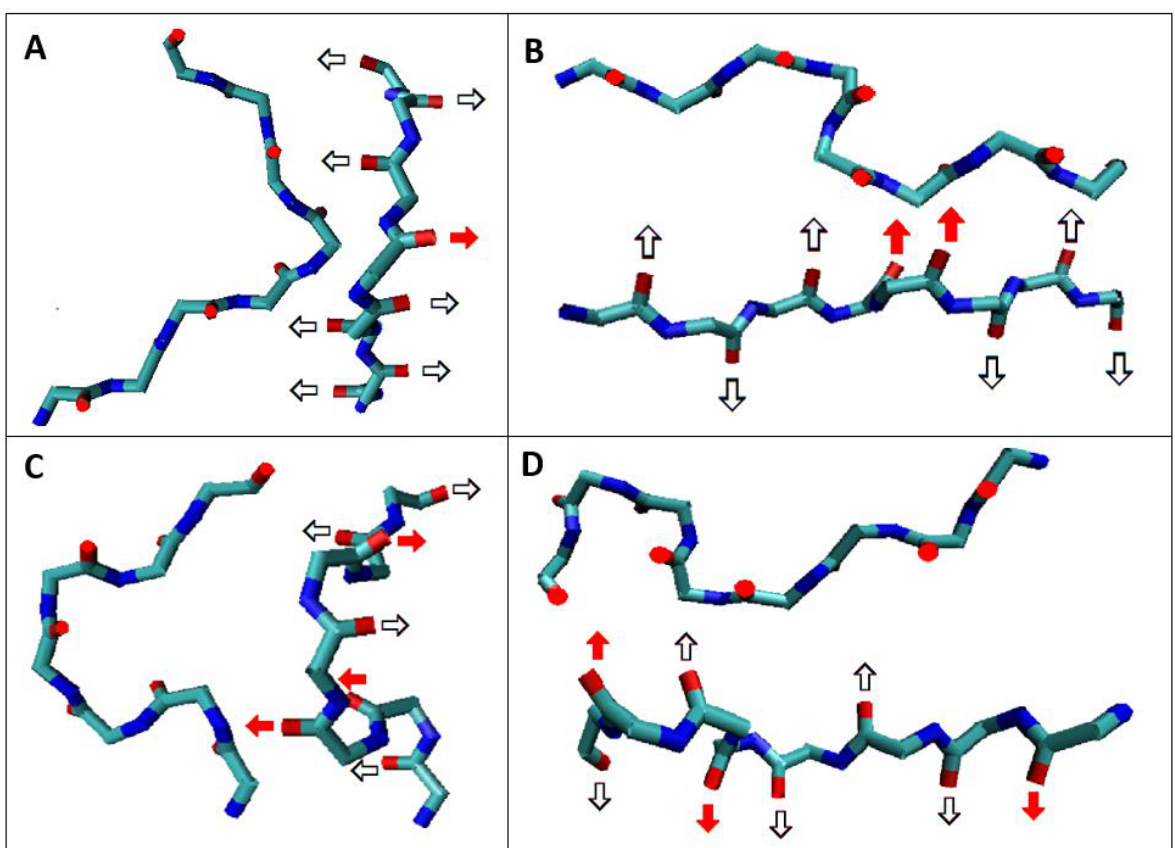
Figure 6. Examples of orientation of hydrogen bonds in fragments of flat structure of polypeptide chain in amyloid as listed in Table 1 in the absence of β -structural forms: ( A ) — (fragment 1 in Figure 4A) AB-L-AB; ( B ) — (fragment 2 in Figure 4A) AB-17L-18R-AB; ( C ) — (fragment 3 in Figure 4A) AB-87L-88R-88B-89L-90B-AB; ( D ) — (fragment 4 in Figure 4A). AB-105M-106L-107B-108AB-109L-110B-111L-112B-113AB. Black and white arrows — orientation resulting from β structures introducing antiparallel system; red arrows — current R or L- α -helix conformation leading to a change of turn while maintaining parallel orientation. Two different spatial orientations of the discussed sections are shown.